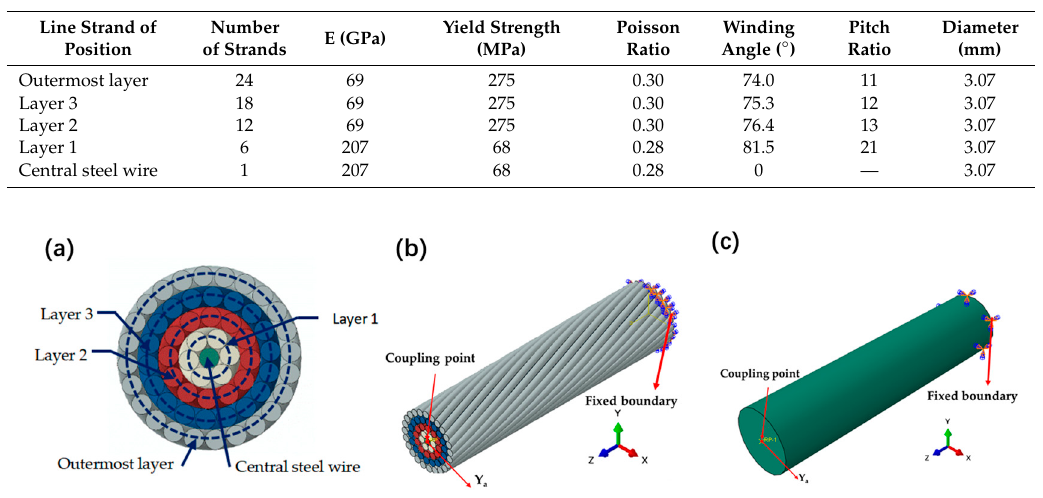
Figure 3. ( a ) Sectional diagram of the local finite element model, ( b ) 3-D local finite element model, and ( c ) the whole microsegment finite element model.